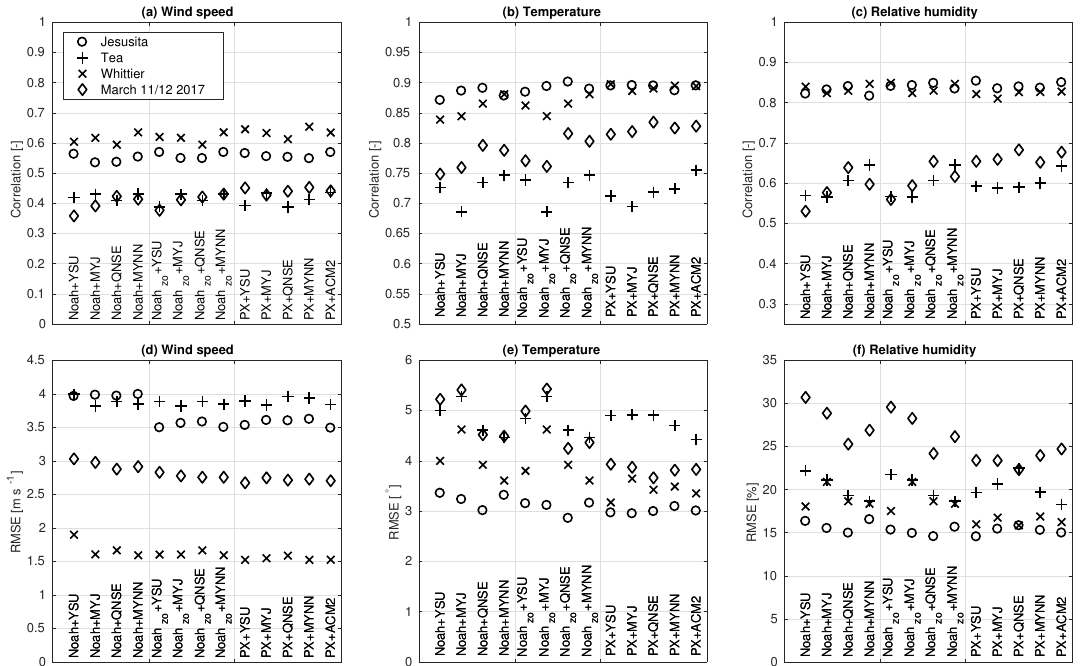
Figure 3. Statistical comparison for all investigated Sundowner events (indicated in the legend in ( a )) for wind speed ( a , d ), temperature ( b , e ), and relative humidity ( c , f ) and the model configurations indicated in each